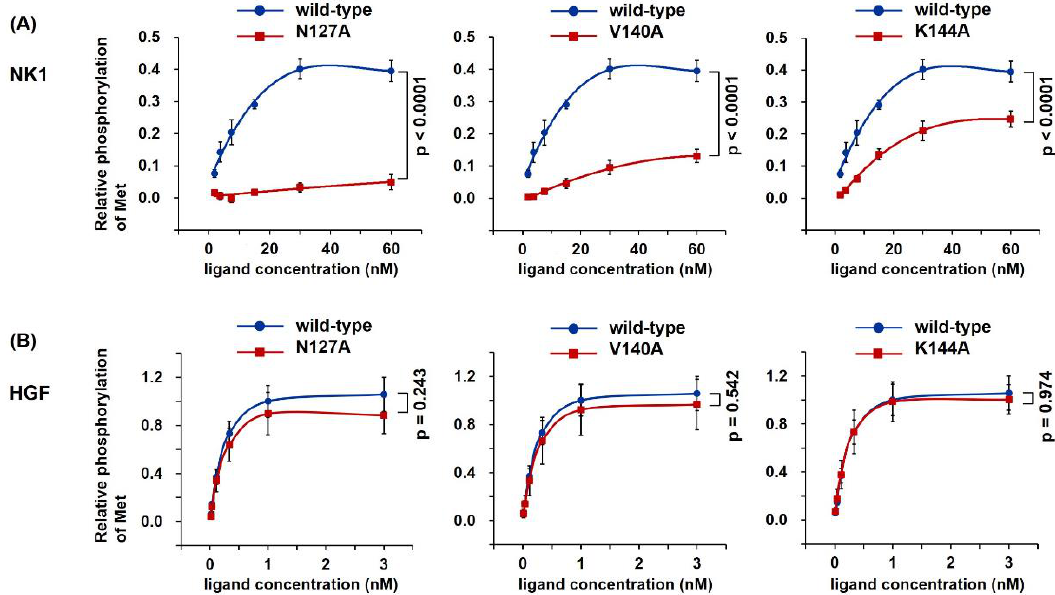
Figure 2. Met receptor activation by wild-type and mutant NK1 ( A ) and HGF ( B ). EHMES-1 cells were treated with recombinant protein for 10 min and Met Tyr1234/1235 phosphorylation was determined by cell-based ELISA. The phosphorylation level induced by 1 nM wild-type HGF was set to 1.0. Data represent mean ± s.e.m [ n = 3, independent experiments, two-way analysis of variance (ANOVA)].